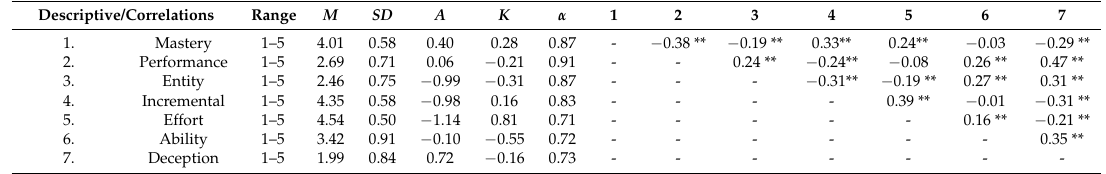
Table 1. Descriptive statistics and bivariate correlations of the